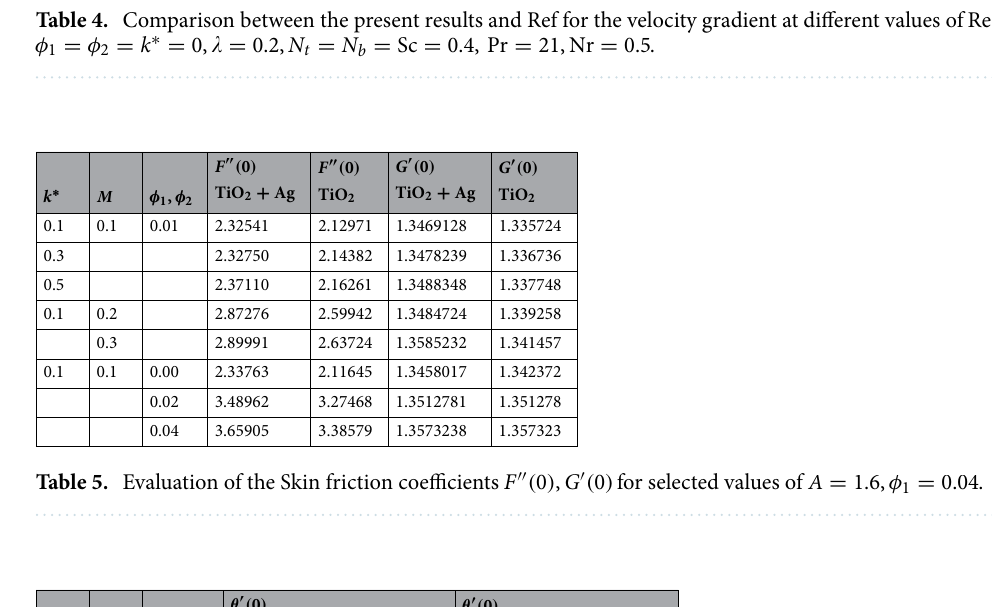
Table 6. Evaluation of the heat transfer rate for selected values of Pr % Increase